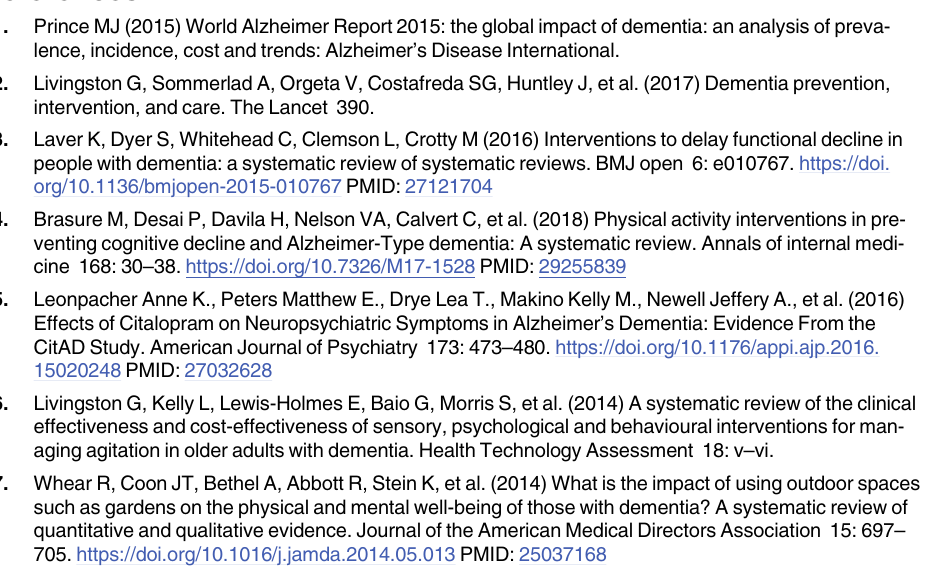
S4 Table. Treatment results. M = Mean (cid:3) Reverse scores used for pooling a 59% ‘disagree’